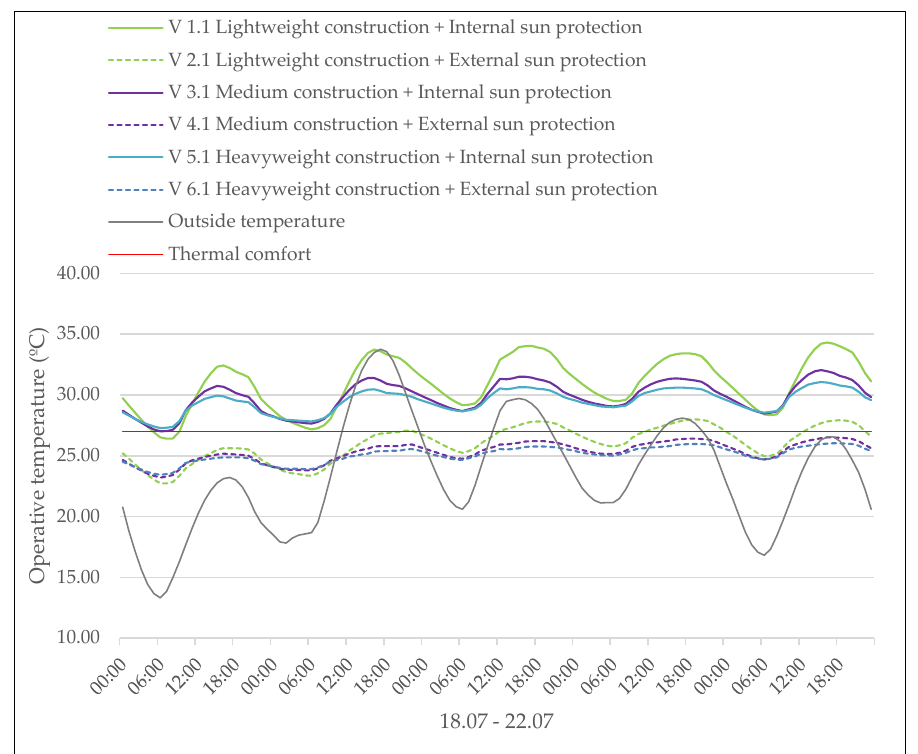
Figure 4. Current climate scenario — Variants of thermal mass and sun protection, based on [33].